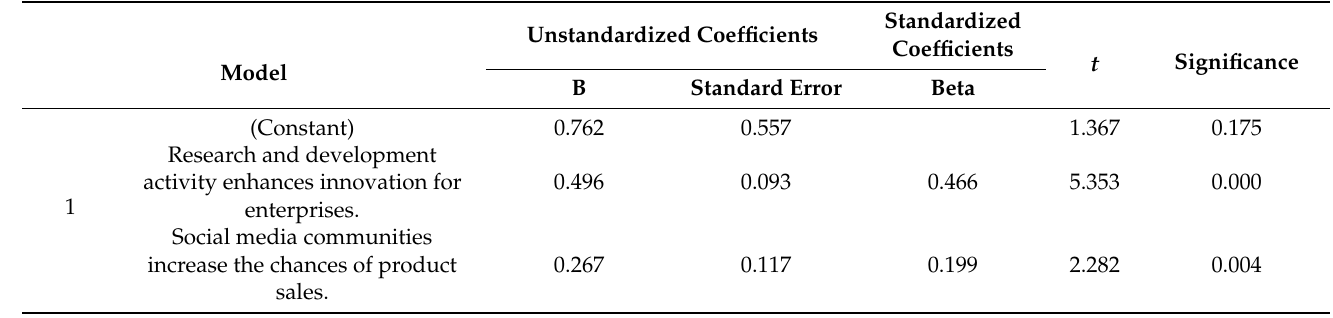
Table 8. The unstandardized and standardized coefficients for hypothesis H3.